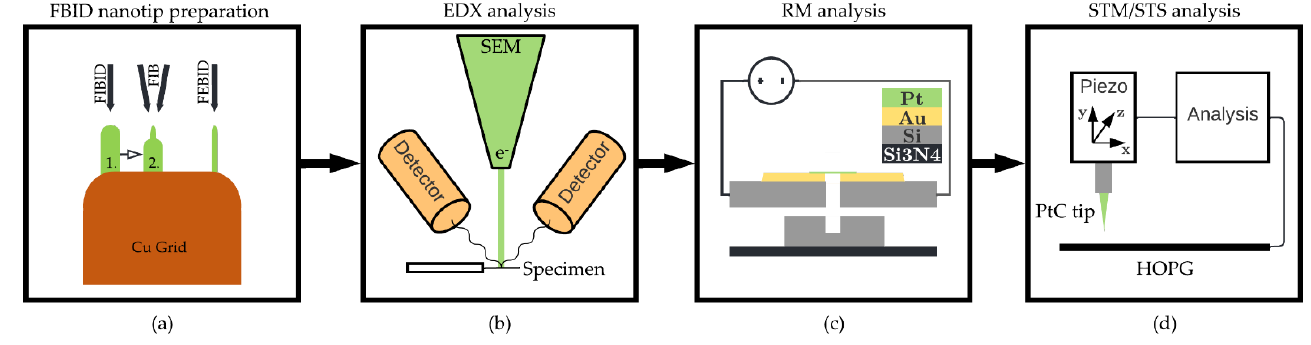
Figure 1. Overview of the applied methods. ( a ) Principle of one-step FEBID and two-step FIBID nanotip preparation. ( b ) Principle of SEM-based EDX analysis. ( c ) Principle of analyzing PtC resistivity by deposition and patterning of nanowires to a PolySi beam on a MEMS chip. ( d ) Principle of STM/STS analysis by deposition of PtC nanotips to a PtIr wire.